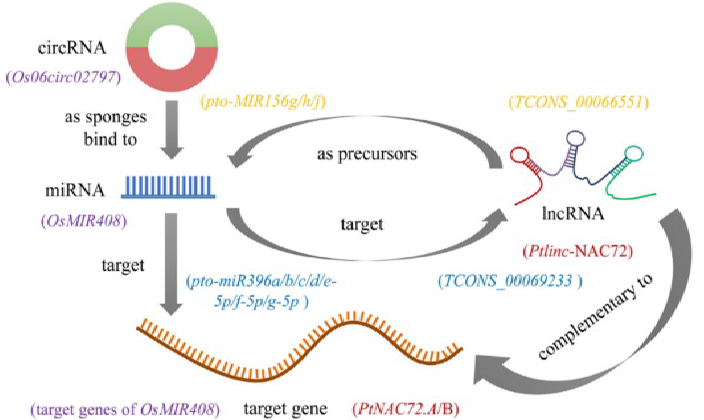
Figure 2. A model of intersections and feedback regulation between stress-responsive miRNAs, lncRNAs, circRNAs, and target genes [61,65,75]. Note: purple words are an example for a circRNA– miRNA–mRNA regulatory network; red, yellow and blue words are examples for lncRNA–miRNA– mRNA regulatory